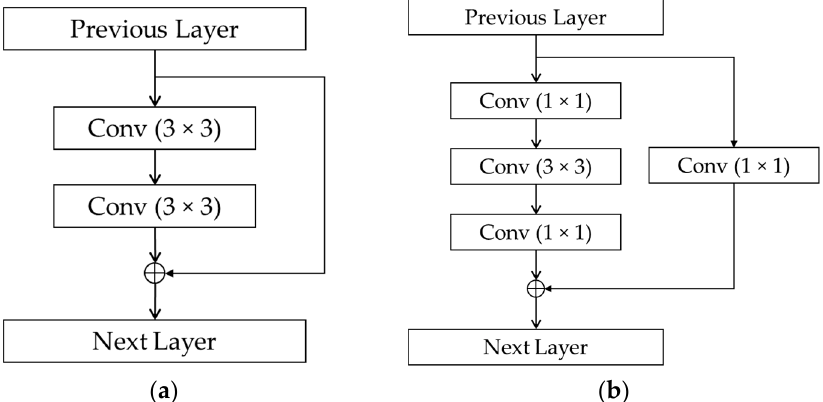
Figure 5. Structures of residual blocks: ( a ) two-layer deep block; ( b ) three-layer deep (bottleneck) block.